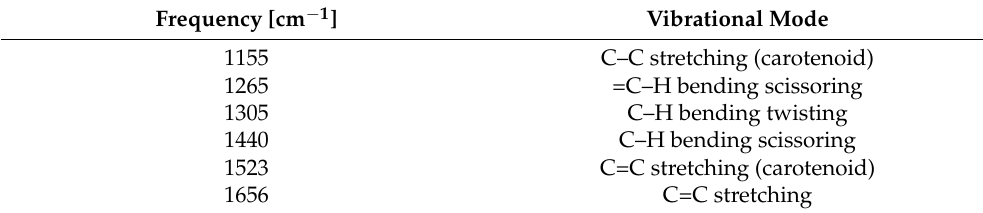
Table 1. Assignment of the Raman bands of the edible oils.